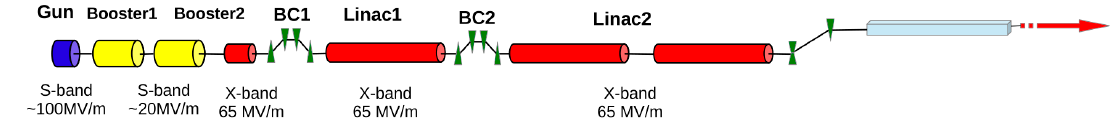
Figure 2. Layout of an XFEL (X-ray Free-Electron Laser) facility.